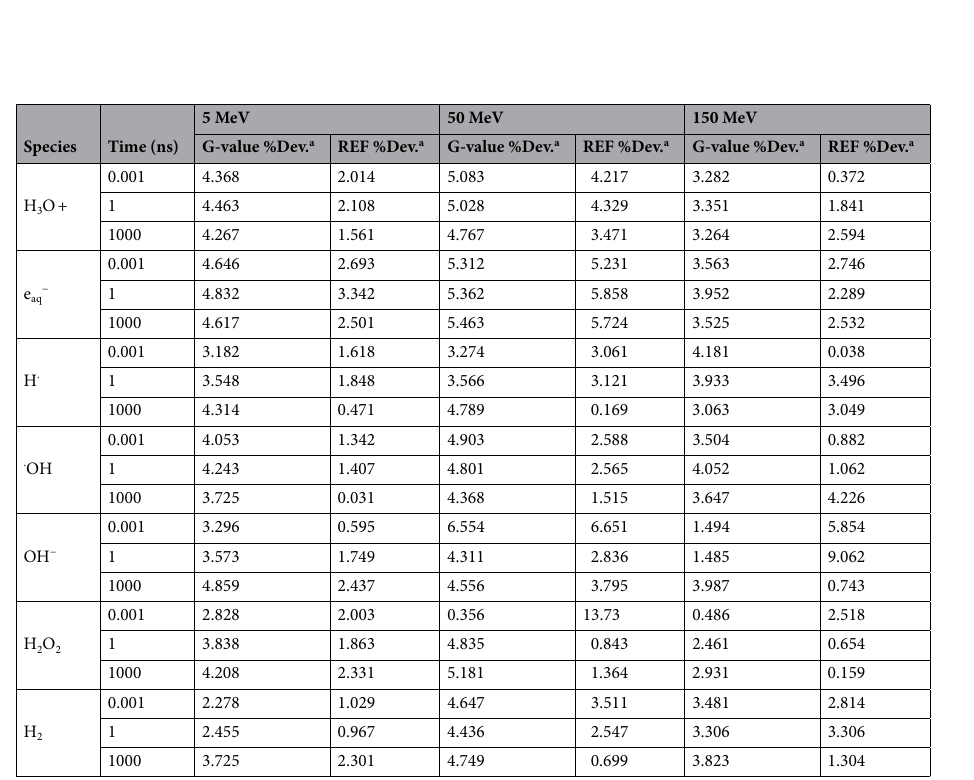
Table 2. Differences of the G-value and REF at 1 ps, 1 ns, and 1 µs around GNP between the Livermore and Penelope models obtained for 5, 50, and 150-MeV proton beams. a Deviation between Livermore and Penelope.